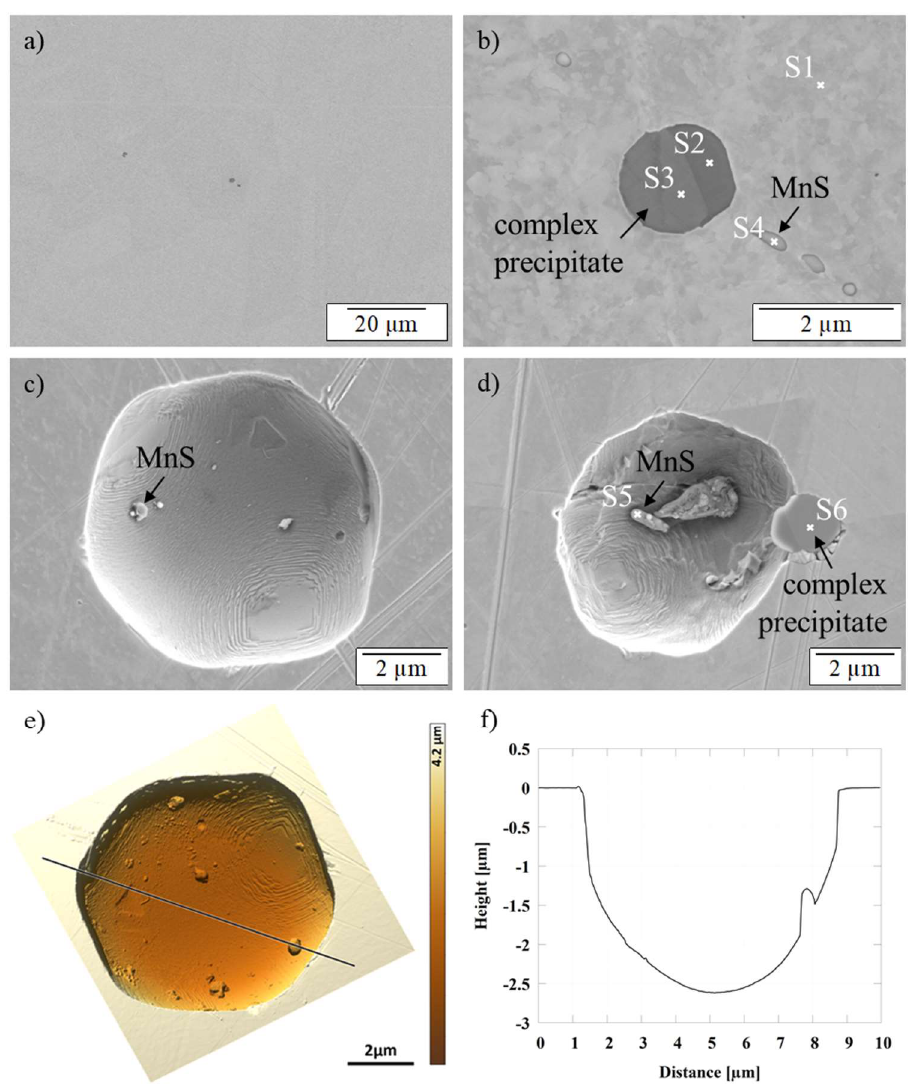
Figure 7. SEM image of the 1.4301 taken by the SE detector (secondary electron detector). ( a , b ) show precipitates on a not tested specimen; ( c , d ) show metastable pits after corrosion testing; ( e ) represents a shaded AFM height image of the pit shown in ( c ), the black line indicates the position of the height profile depicted in ( f